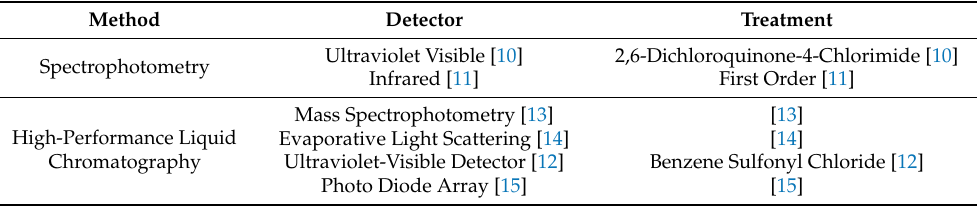
Table 1. Reported previous analyses of tranexamic acid.